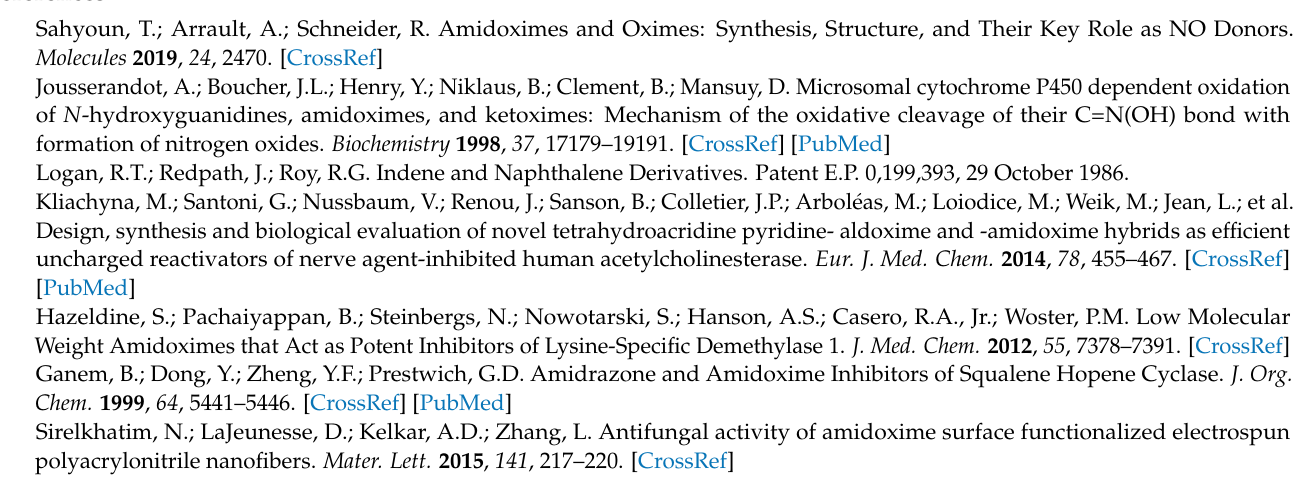
concentration of studied compounds (mg L − 1 ). Figure S2: Example of an agarose gel electrophoresis separation of isolated plasmids DNA from R4 strains modified with selected coumarin derivatives. Figure S3: Example of an agarose gel electrophoresis separation of isolated plasmids DNA from R4 strains modified with antibiotics: cloxacillin, ciprofloxacin, and bleomycin digested (or not) with repair enzymes Fpg. 1 H and 13 C NMR spectra of compounds 1 – 26